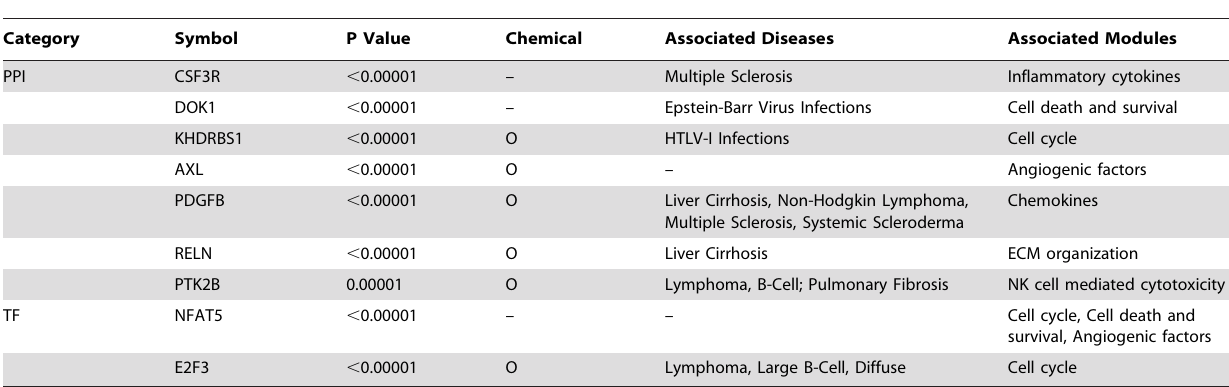
Table 3. Novel molecular target candidates for diagnosis and therapy of